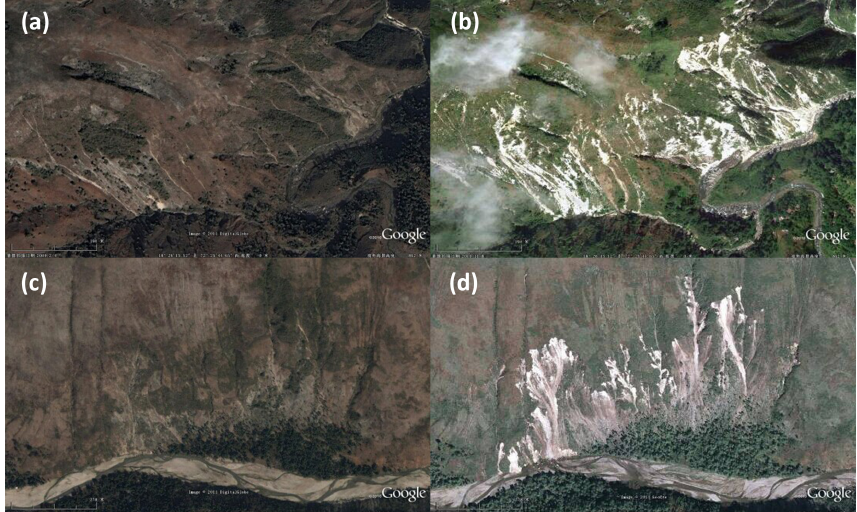
Figure 7. Development of shallow disrupted landslides. The first site is located at 18 ◦ 26 0 13.52 00 N, 72 ◦ 25 0 44.65 00 W as shown in (a) and (b) . The dates of the images are 4 February 2009 and 8 November 2010, respectively. The second site (shown in c and d ) is located at 18 ◦ 28 0 29.18 00 N, 72 ◦ 30 0 47.24 00 W; they were taken on 4 February 2009 and 13 January 2010, respectively (upwards is north for all four images.